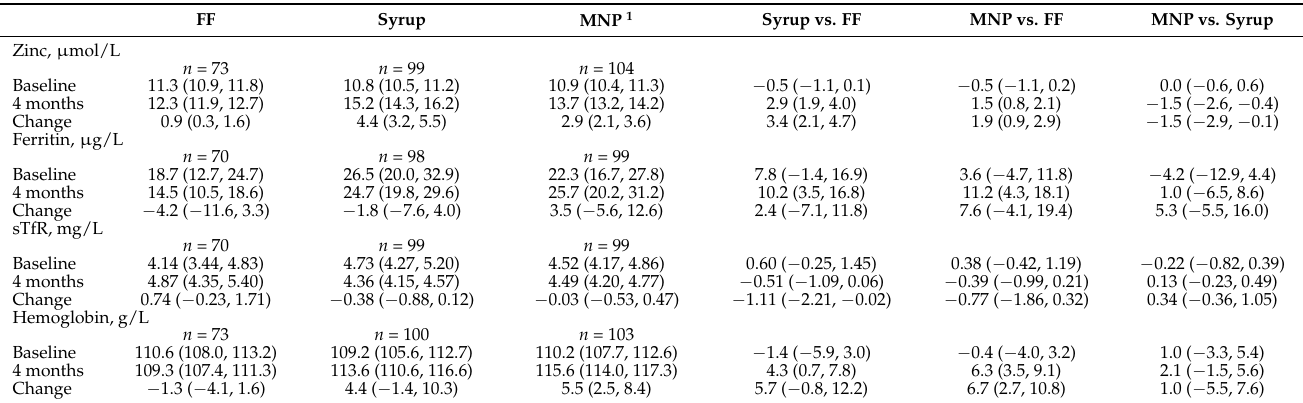
Table 3. Geometric mean concentration of serum zinc, ferritin, soluble transferrin receptor, and hemoglobin at baseline and follow up samples measured at 4 months, by study group.